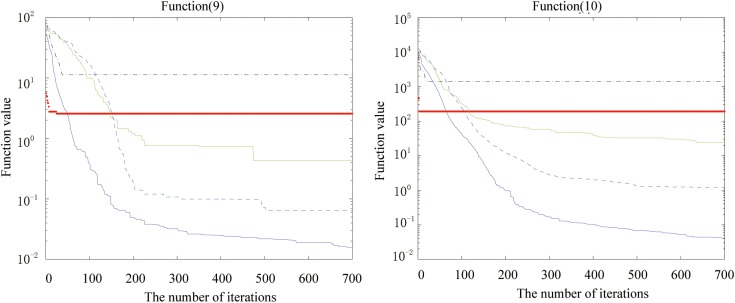
The fitness value of various algorithms for Alpine and Powell during increasing iterative times.